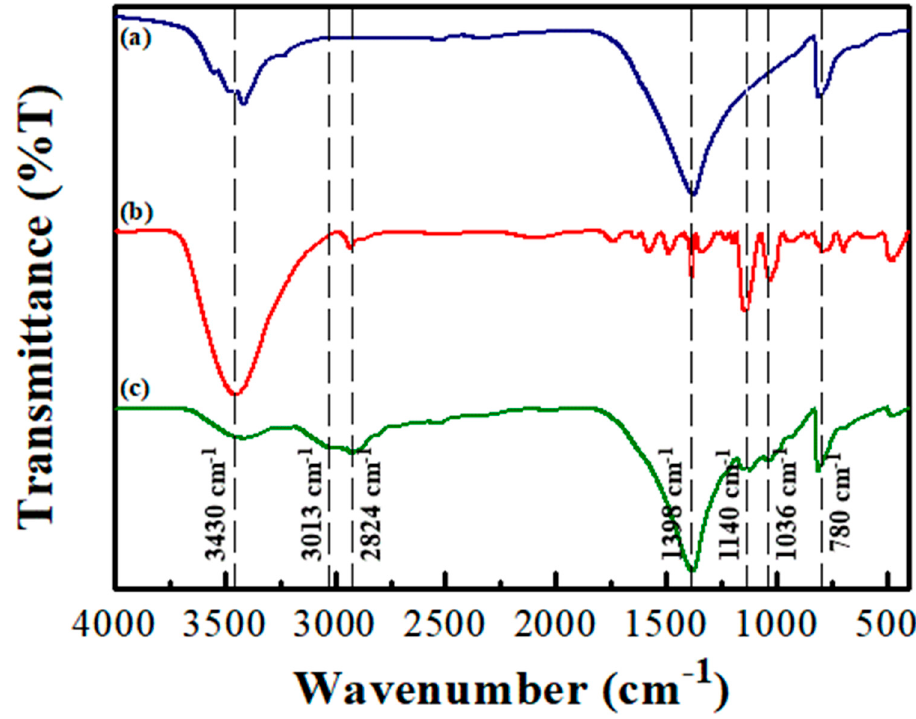
Figure 2. FTIR spectra. ( a ) Acid-treated OH–BN; ( b ) APTES; ( c ) silane-modified Si–BN.